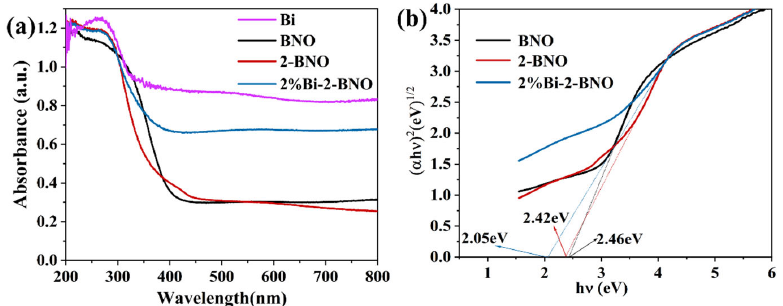
Figure 5. ( a ) Optical absorption spectra of the BNO, 2-BNO and 2% Bi-2-BNO samples and ( b ) the corresponding plots of ( α h υ ) 1/2 vs. energy (h ν ).